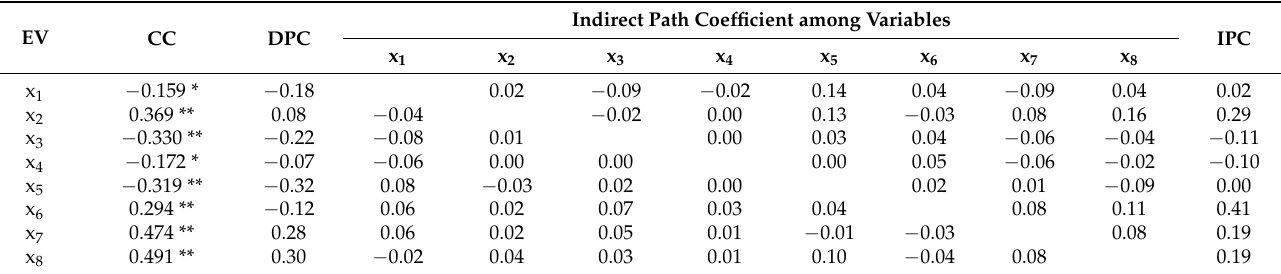
Figure 4. Path analysis of urban land expansion. Note: x 1 : farmland area, x 2 : technology investment, x 3 : distance to city center, x 4 : transportation accessibility, x 5 : average fixed-asset investment, x 6 : land finance scale, x 7 : urban population, x 8 : added value of secondary and tertiary industries. Table 3. Path analysis of urban land